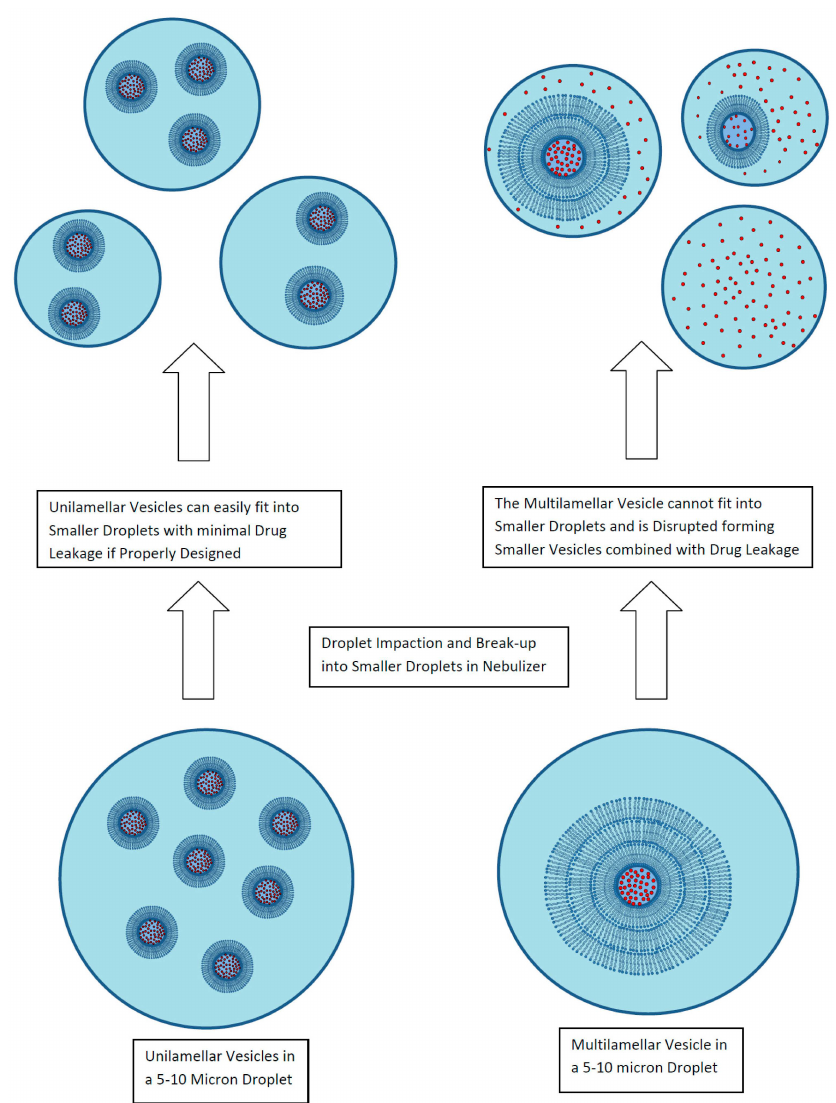
Figure 5. Liposome disruption during exposure to nebulization. Reprinted with permission from [30]. Copyright 2013 Future